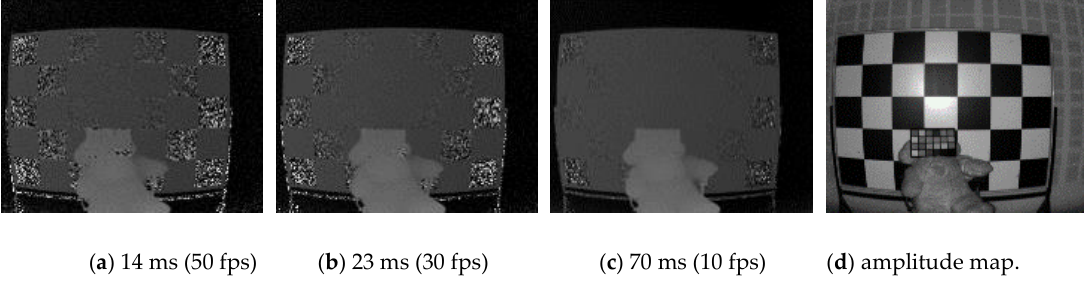
Figure 3. ToF depth error by integration time.